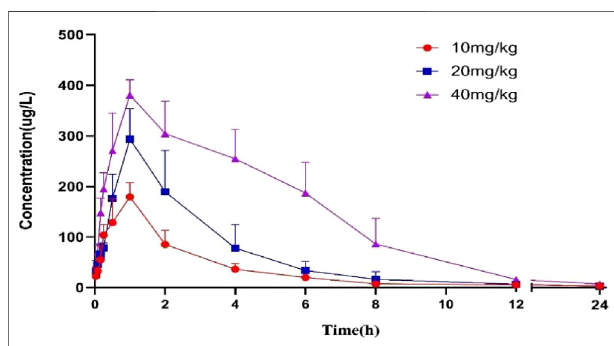
FIGURE 8 | Mean plasma concentration – time curves after oral administration of YWS01125 (10, 20, and 40 mg/kg) to C57BL/6J mice (mean ± SD, n =